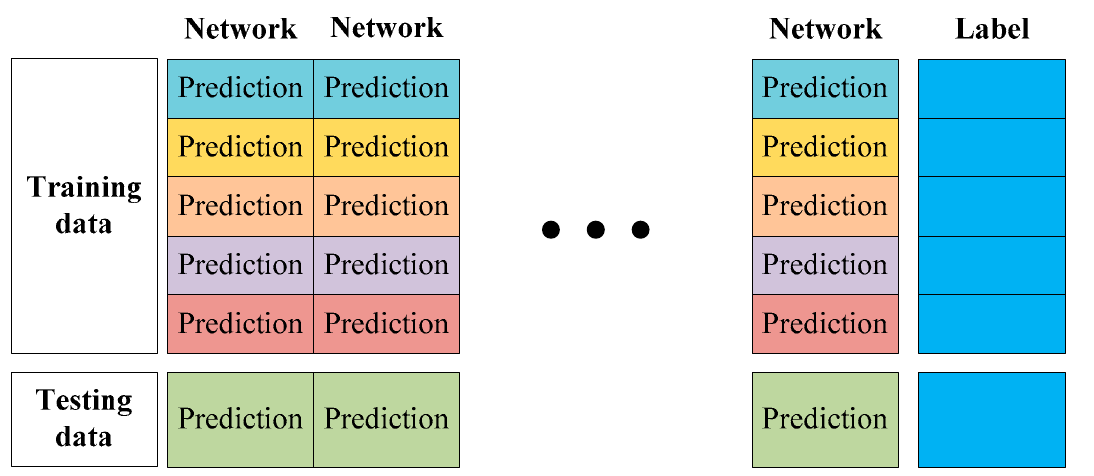
Figure 6. Composition of generated training and testing data for ensemble learning.